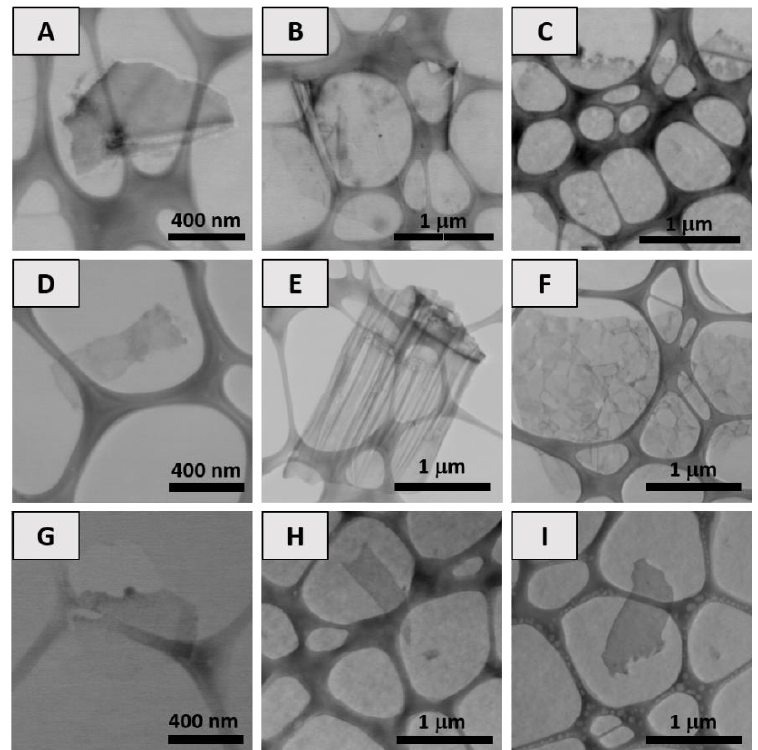
Figure 1. SEM-STEM micrographs for the different synthesized graphene oxides. ( A , B , C ) GO1, ( D, E, F ) GO2, and ( G, H, I ) GO3.